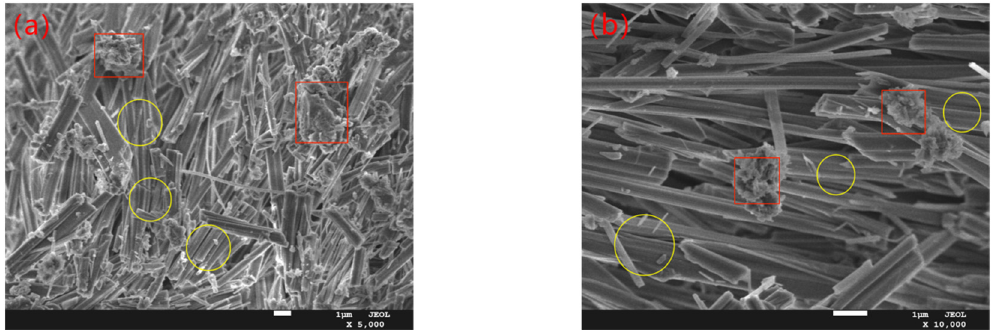
Figure 11: Morphology of hydration products of GOPARMs doped with 0.03 wt% GO ( very dense and orderly distribution of hydration products ) : ( a ) × 5k; ( b ) × 10k ( yellow circles: AFt and red rectangles: other amorphous hydration products )